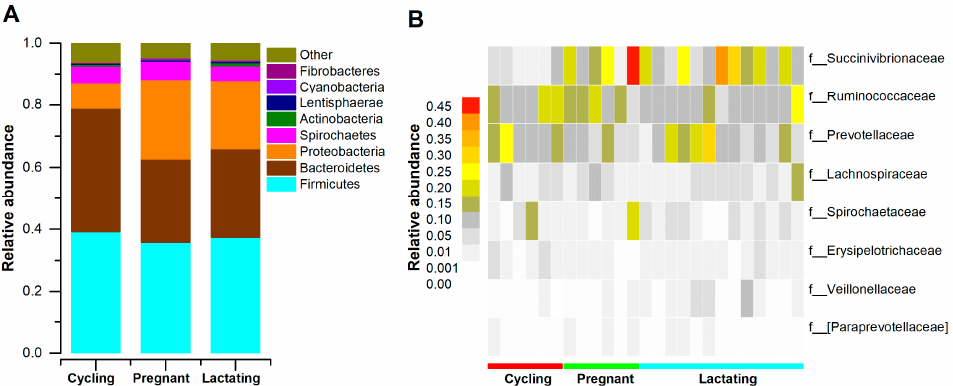
Figure 1. The distributions of main phyla and families in different reproductive states. ( A ): Relative abundance of gut microbial taxa at the phylum level. Stacked bar graphs illustrate the abundances of phyla, and x-axis represents the samples. ( B ): The distributions of families (the average relative of all fecal samples > 0.01). A heatmap was used to show family patterns.